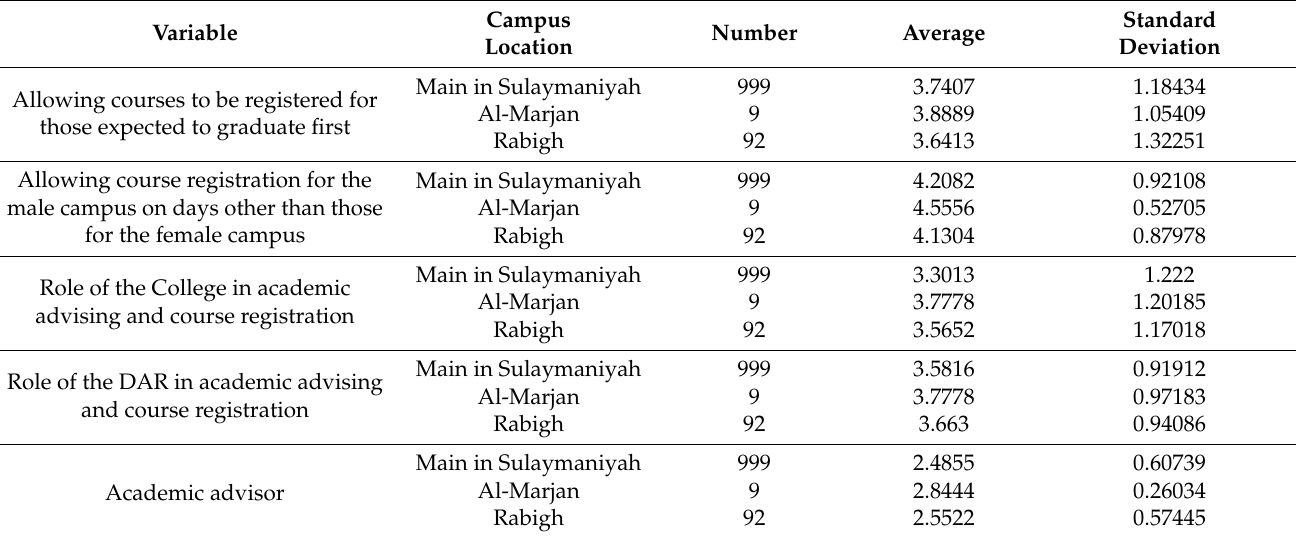
Table 19. Metadata of study variables by campus location.